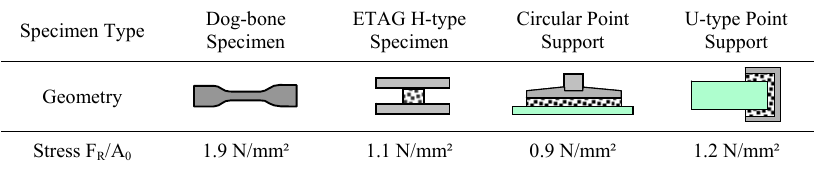
Table 2: Limit normal stresses (experimental